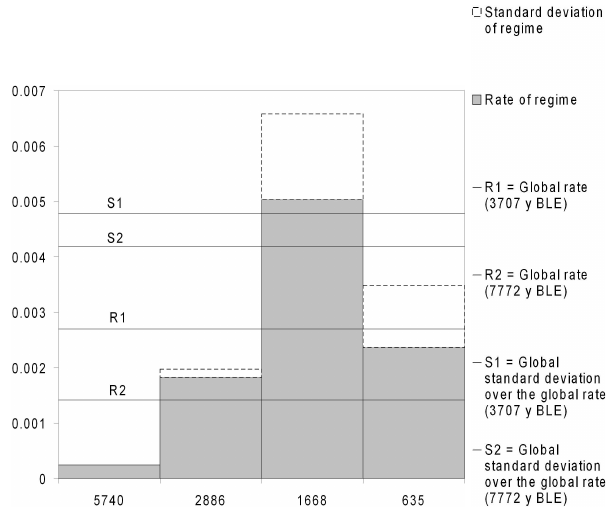
Fig. 2. Rates and standard deviation for each regimen (vertical axis) versus the time of the central point of each regimen (horizontal